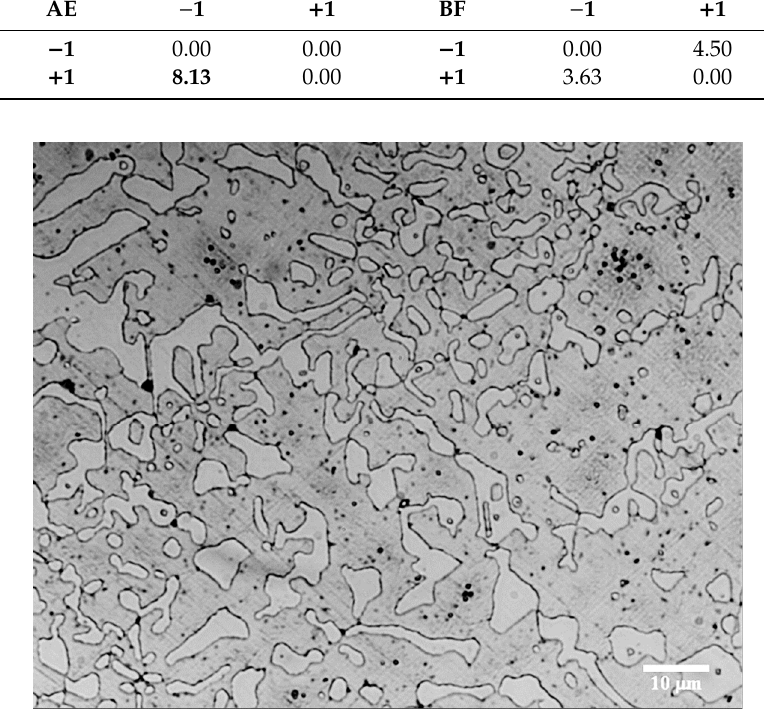
Figure 7. Microstructure obtained after the softening treatment, followed by austenitization at 1100 °C for 8 h and oil cooling. The redissolution of the carbides precipitated during the softening treatment can be observed.